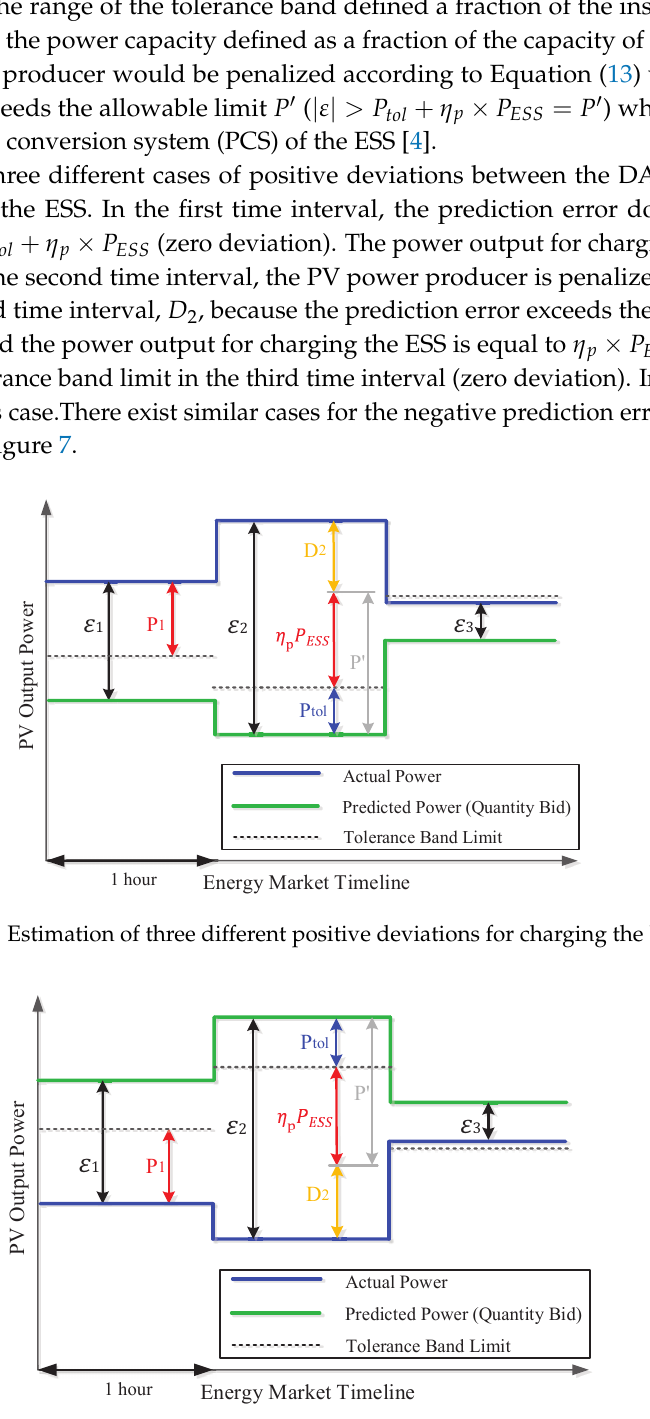
Figure 7. Estimation of three different negative deviations for discharging the